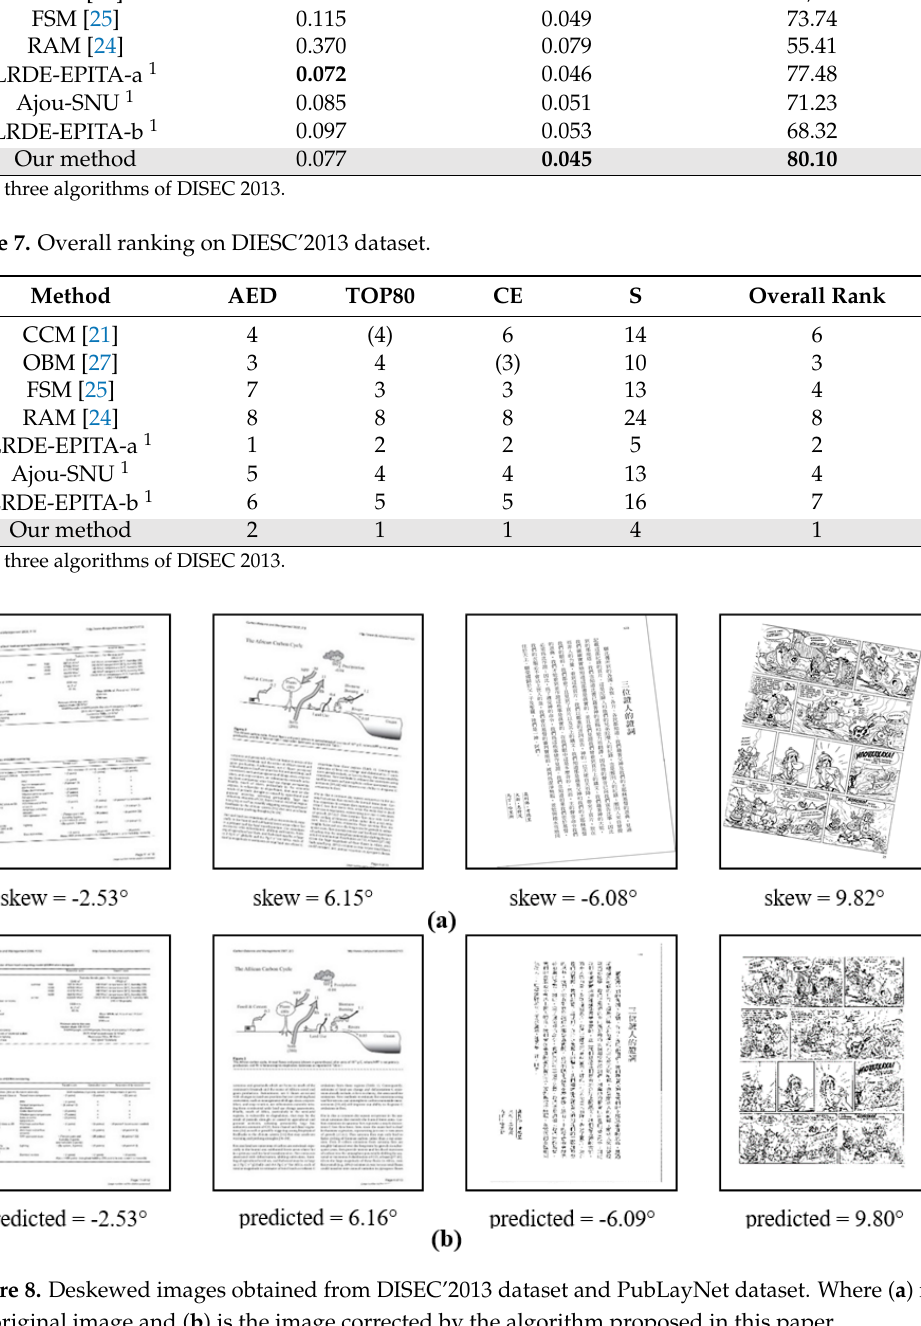
Table 7. Overall ranking on DIESC’2013 dataset.